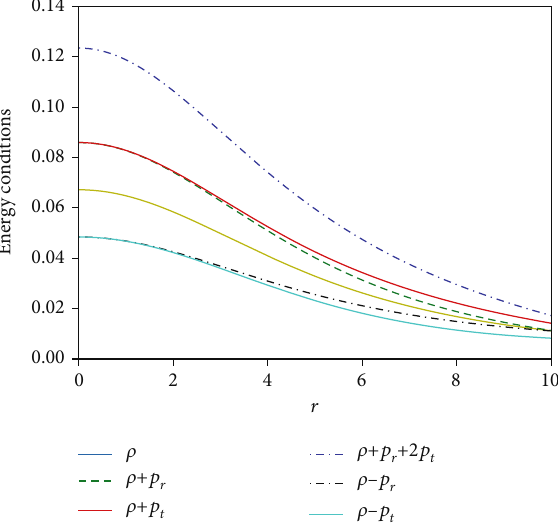
− v 2 j against radial distance r . r t